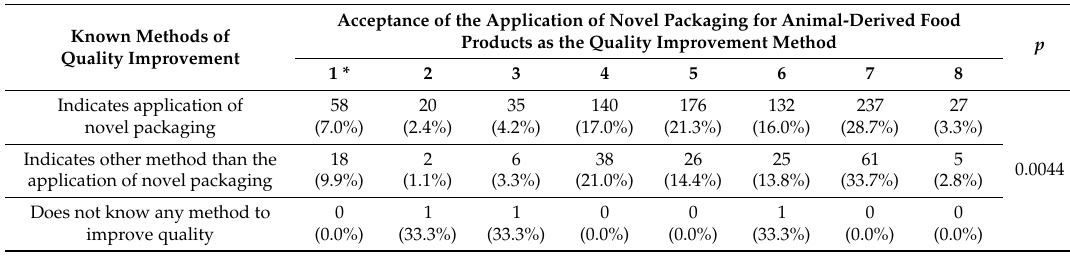
Table 6. Level of acceptance of novel packaging for animal-derived food products for